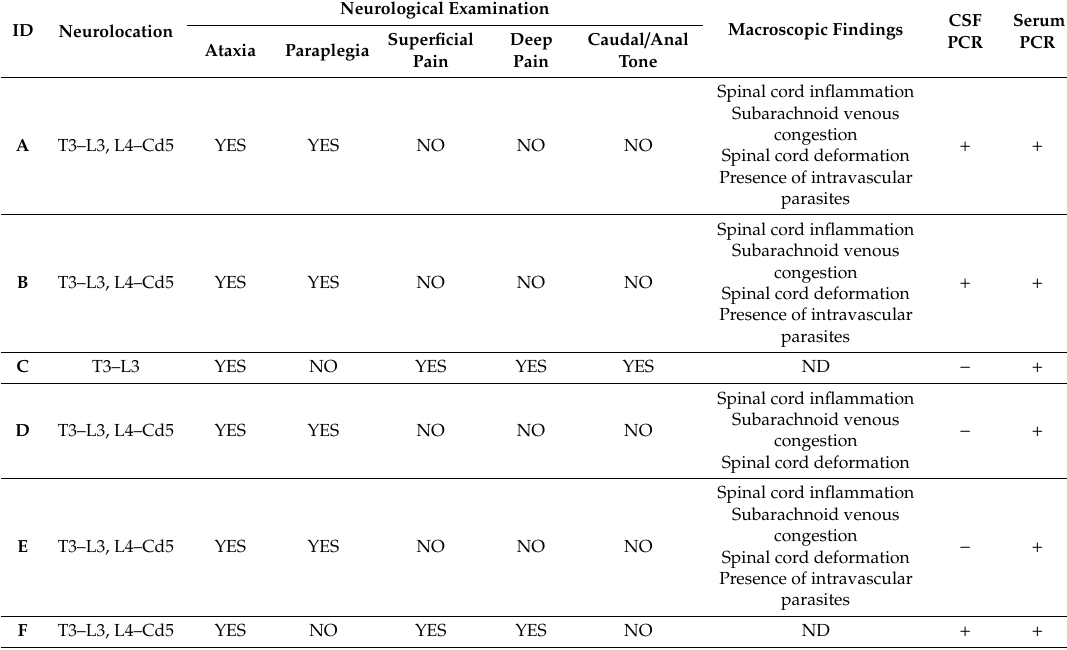
Table 2. Clinical, macroscopic and molecular findings in domestic feline patients with a presumptive diagnosis of feline